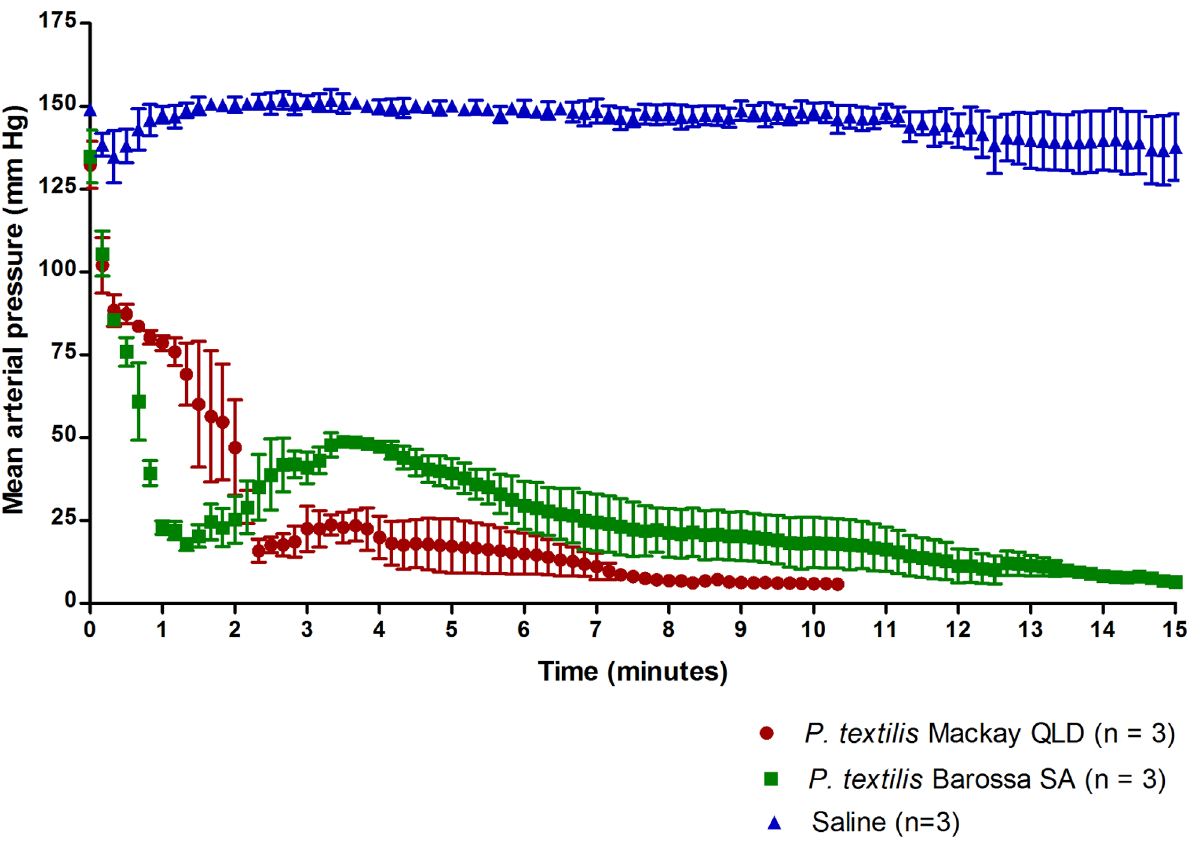
Figure 4. Mean arterial blood pressure in rats injected with 0.5 mg venom under the dorsal skin. Injection volume: 100 m l, vehicle: saline. Rats anaesthetised with 80 mg/kg ip pentobarbitone sodium.